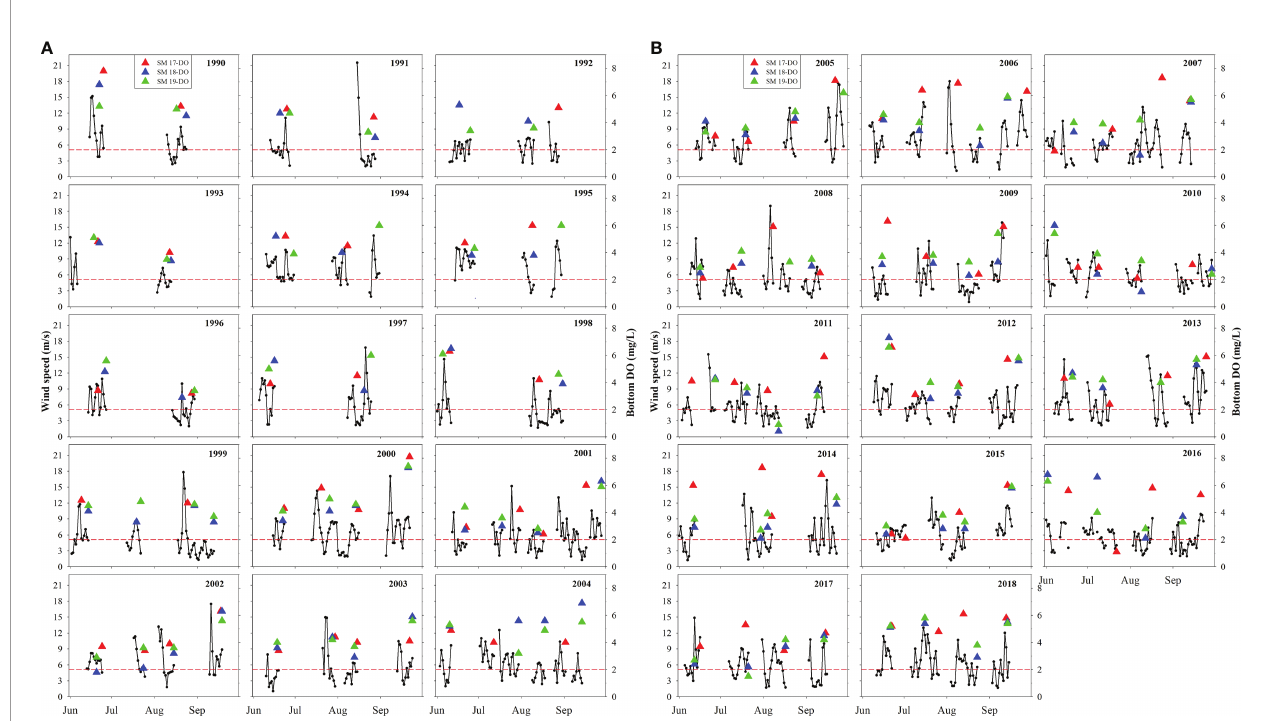
FIGURE 4 | (A) Wind speed prior to the DO sampling and bottom DO during 1990-2004 in summer at SM17, SM18 and SM19 (the red dashed line denotes the level of DO=2 mg/L). (B) Wind speed prior to the DO sampling and bottom DO during 2005-2018 in summer at SM17, SM18 and SM19 (the red dashed line denotes the level of DO=2 mg/L).